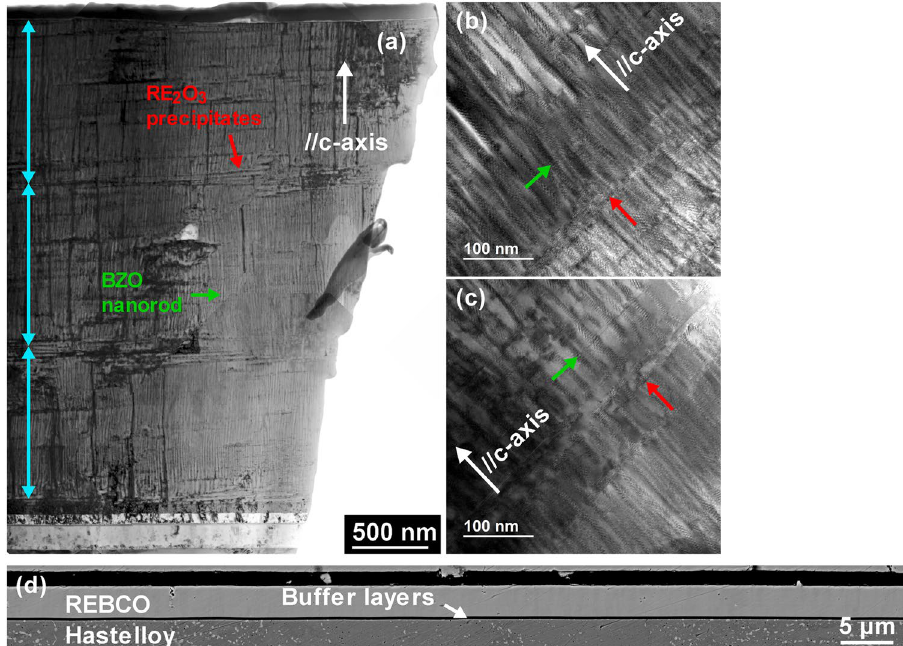
Figure 2. ( a ) Low magnification cross-section TEM image viewed along the current-flowing direction. ( b ) High magnification cross section TEM image of the REBCO film grown in a pass. ( c ) High magnification cross section TEM image of the REBCO layer at the interface between two passes. ( d ) Back-scattered electron image of film cross section to emphasize the homogeneous microstructure and the absence of large misoriented grains and big second phase particles acting as current blocking effects. Occasional small second phase particles with size below 1 μ m are observed. All cracks and scratches in ( d ) are from sample